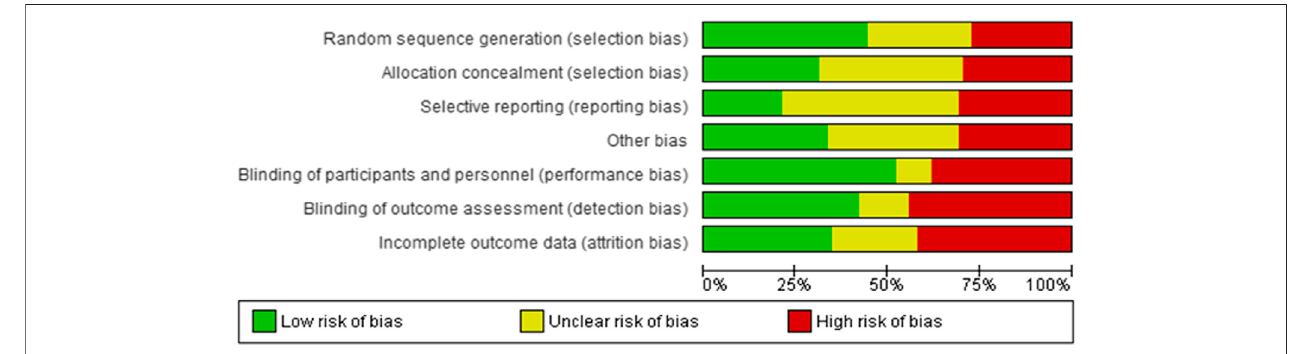
FIGURE 2 | Overall risk of